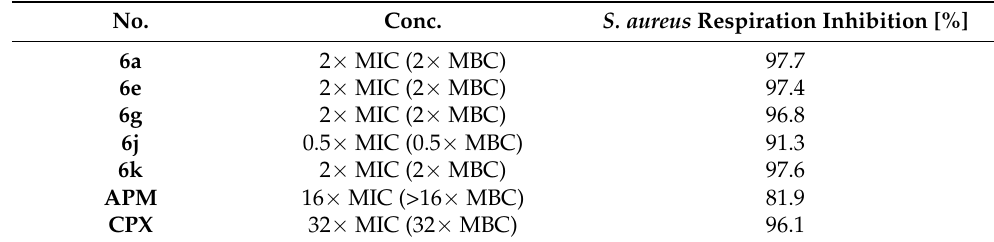
Table 2. Lowest MIC values with at least 70% inhibition of S. aureus ATCC 29213 respiratory activity. No.